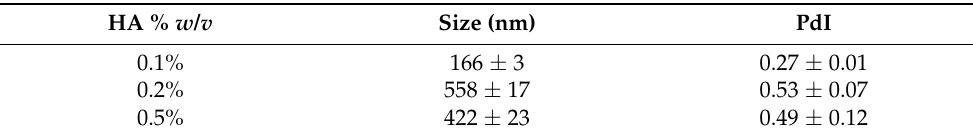
Table 4. Physical characterization of LP-TQ-HA liposomes using different percentages of HA (Mean ± SD, n =